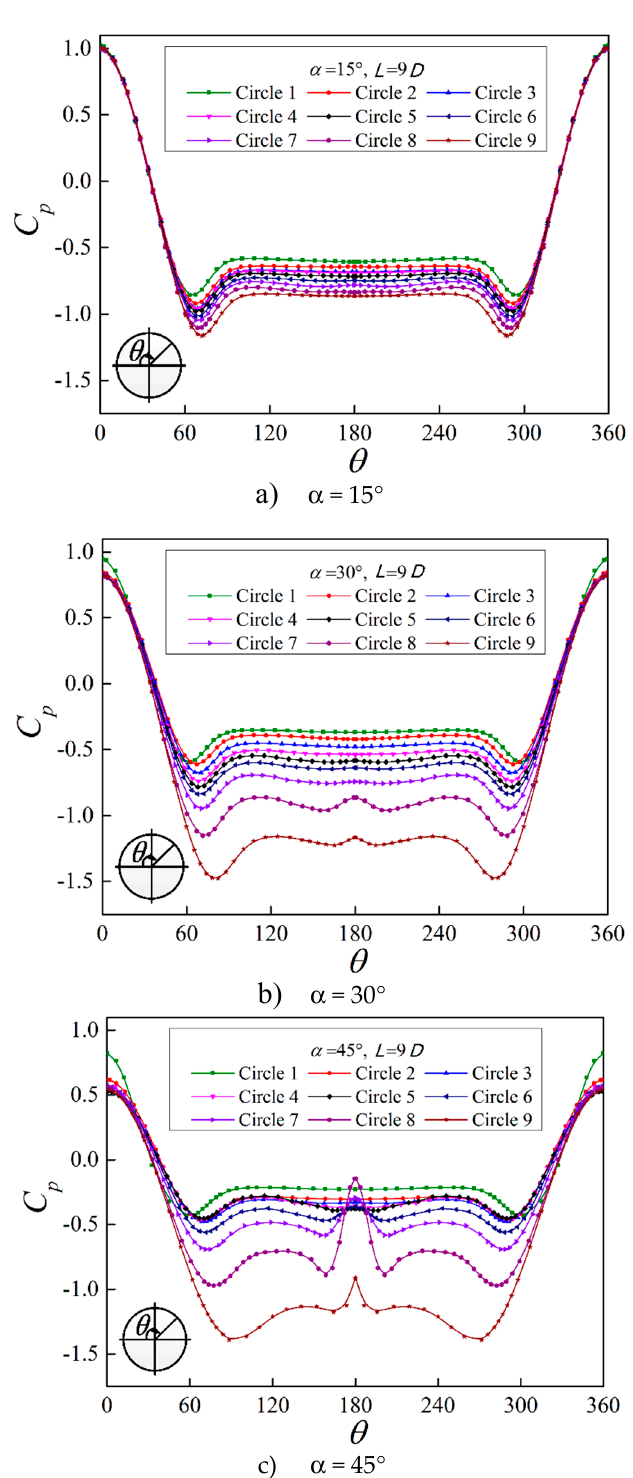
Figure 11. Pressure distribution on the cylinder wall under nonslip boundary condition.